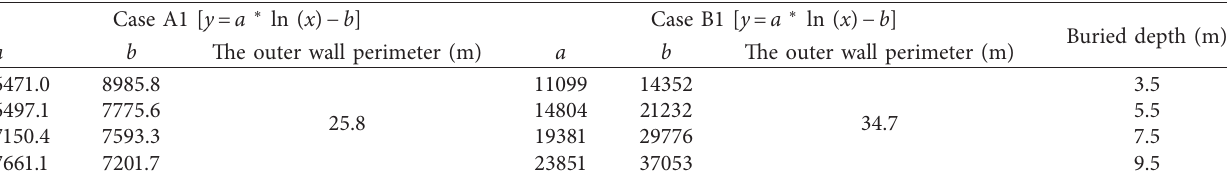
Table 14: The logarithmic function coefficients a and b of the jacking